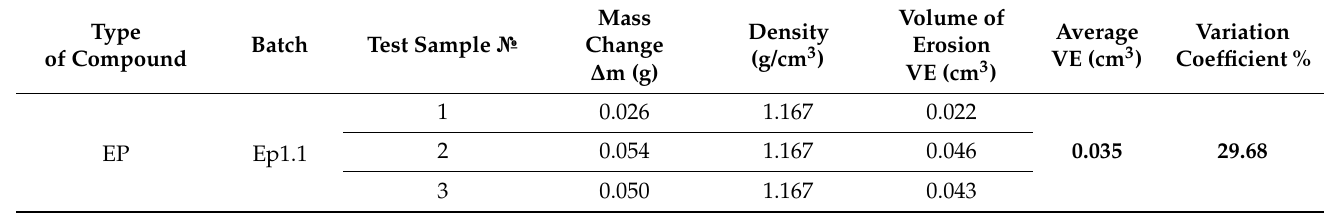
Table A3. Wear of unfilled epoxy binder (EP) at 100 ◦ C at an impingement angle of 90 ◦